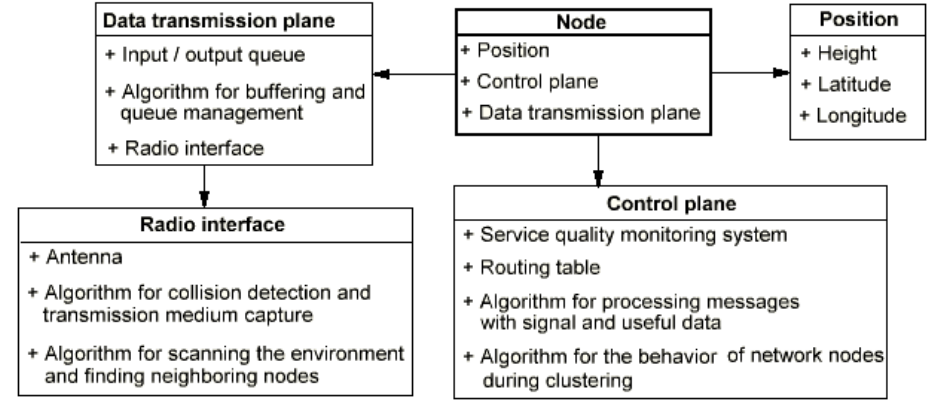
Figure 7. Network node functioning scheme.